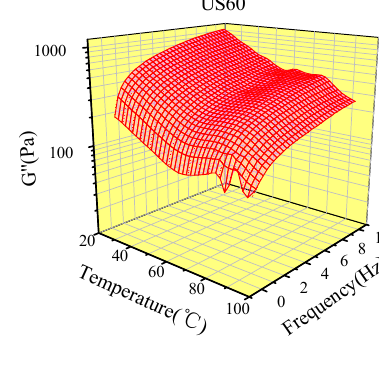
Figure 6. Loss module of ultrasound treated gluten samples as a function of temperature and